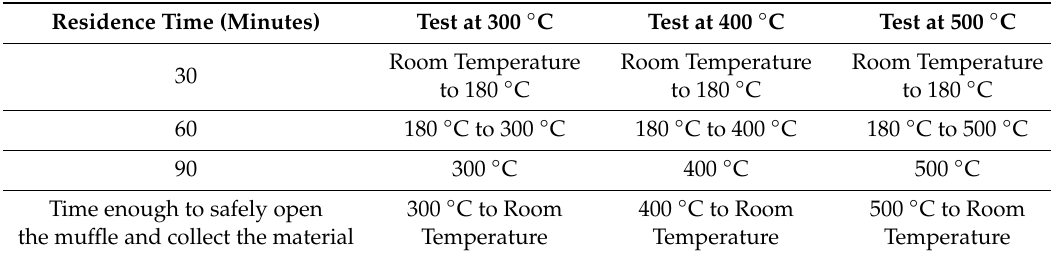
Table 1. First series of conversion